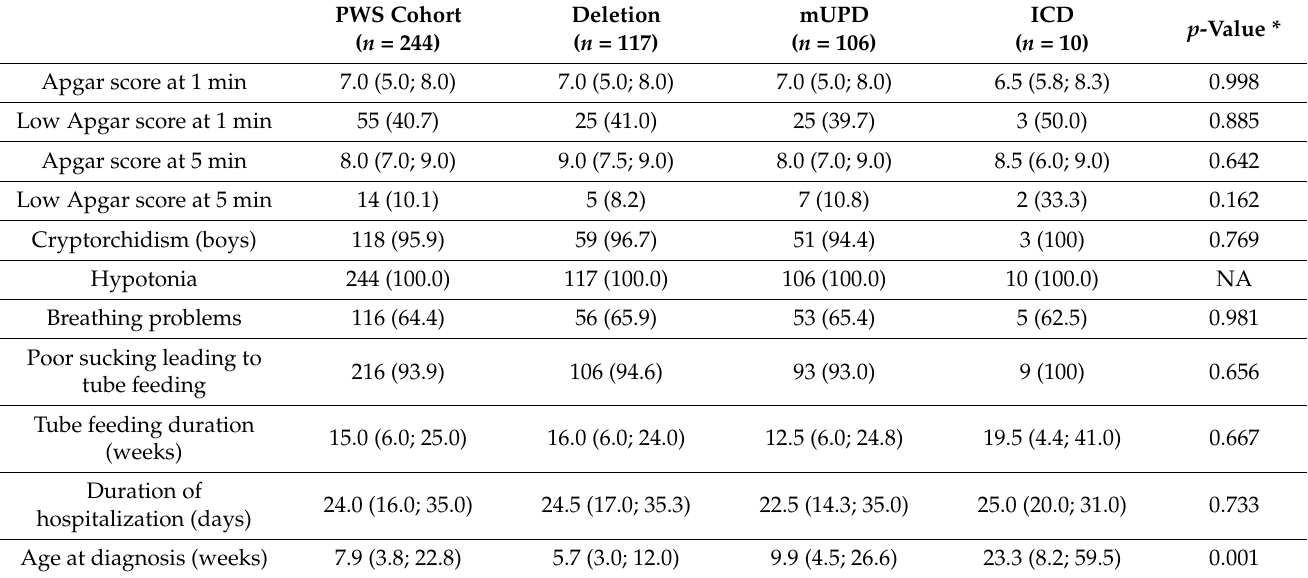
Table 3. Neonatal characteristics of the PWS cohort and between the different